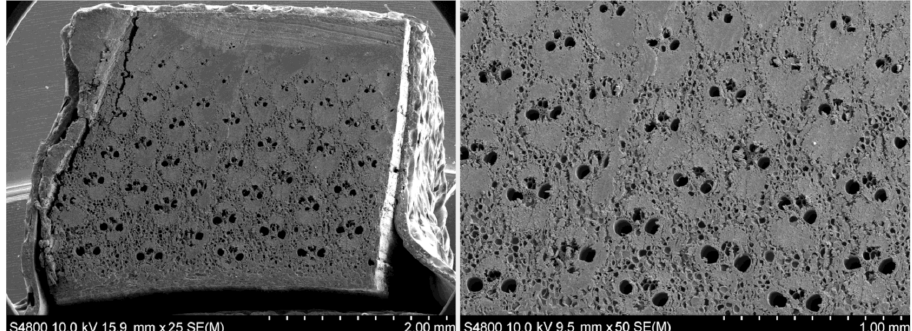
Figure 5. SEM images of transversal cut of PA bamboo with different magnifications.